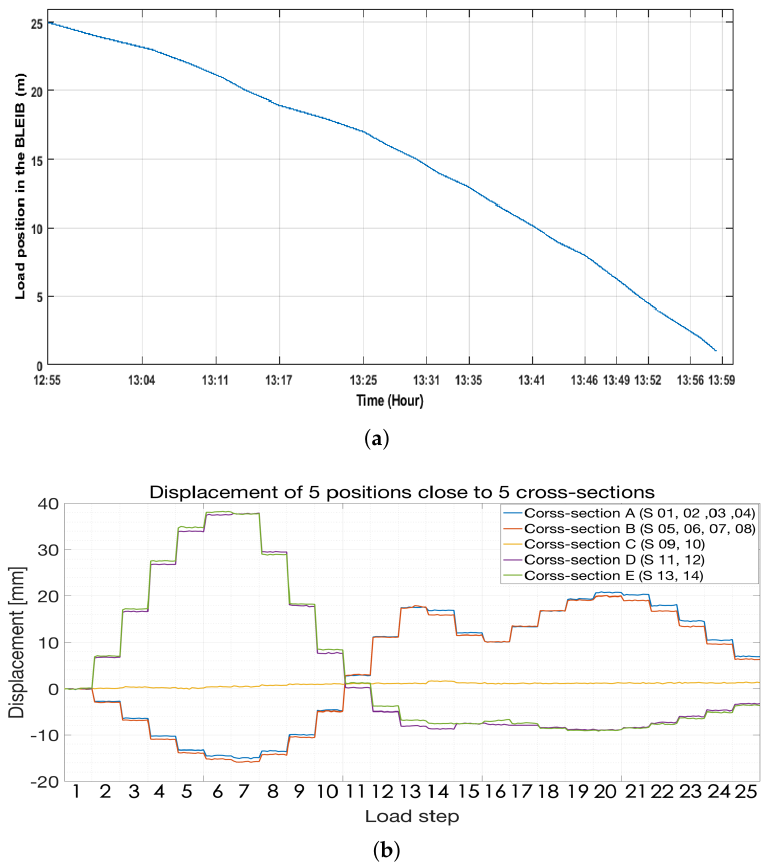
Figure 8. Quasi-static load position and displacement values are shown. ( a ) Quasi-static load position and time in the BLEIB structure; ( b ) Displacement value measured by DIC.